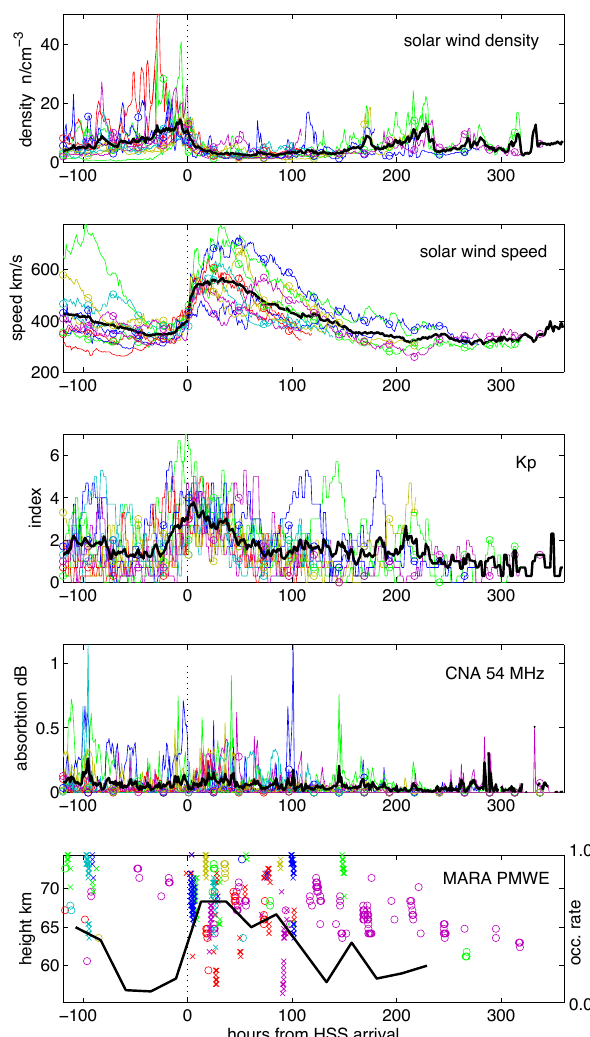
Figure 5. Superposed measurements for 12 high-speed solar wind streams, aligned at the time of onset (defined by the solar wind speed increasing through 450kms − 1 ) and covering the period from 5 days before to 15 days after the onset. Time series are truncated if a new high-speed stream or enhanced solar proton fluxes arrive. First panel: hydrogen density in the solar wind; second panel: solar wind speed; third panel: geomagnetic Kp index; fourth panel: CNA at 54MHz measured using MARA receivers; fifth panel: heights and times of PMWE detections using MARA (coloured symbols and left-hand axis) and the fraction of the events when PWME were observed each 24h (black line, right-hand axis). Different colours and symbols (X, O) indicate the different events; see Table 2. Black curves show averages over all